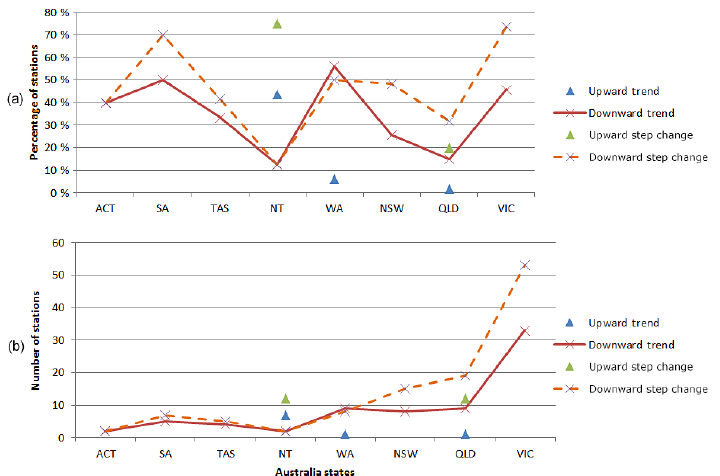
Figure 7. (a) Percentage and (b) number of stations showing significant upward and downward trends or step changes in Australian states and